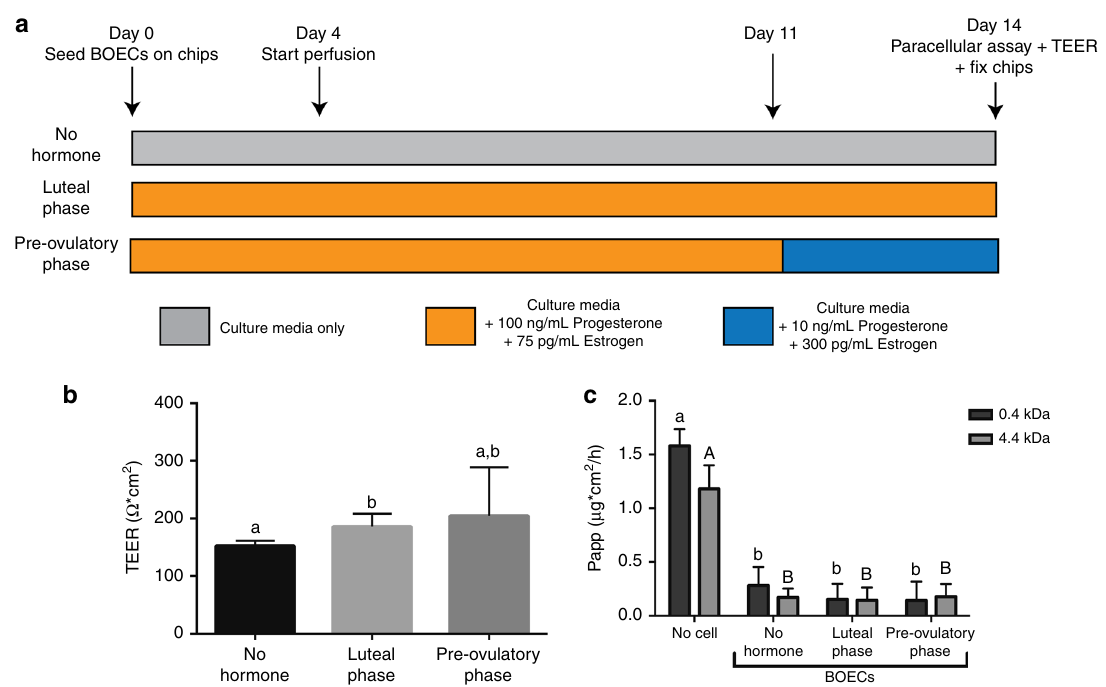
Fig. 2 Hormonal stimulation experimental design and effects on the trans-epithelial electrical resistance (TEER) and paracellular permeability (Papp). a Experimental design for mimicking the luteal and pre-ovulatory phases. b TEER measurements in the micro fl uidic devices under the three conditions; values were adjusted for the resistance found in an empty device ( F = 14.503, p < 000.1; ANOVA followed by a post-hoc Tukey test). c Apparent permeability (Papp) of 0.4 and 4.4 kDa fl uorescent markers in devices without cells (no cell) or in the presence of bovine oviductal epithelial cells (BOECs) under the three experimental conditions ( F = 0.537, p = 0.590 and F = 0.583, p = 0.564 for 0.4 and 4.4 kDa, respectively; ANOVA followed by a post-hoc Tukey test). Graphs of b and c display average + s.d. Different letters (a vs b in b ; a vs b and A vs B in c ) indicate statistically signi fi cant differences ( n = 6 devices per condition and pool, p <